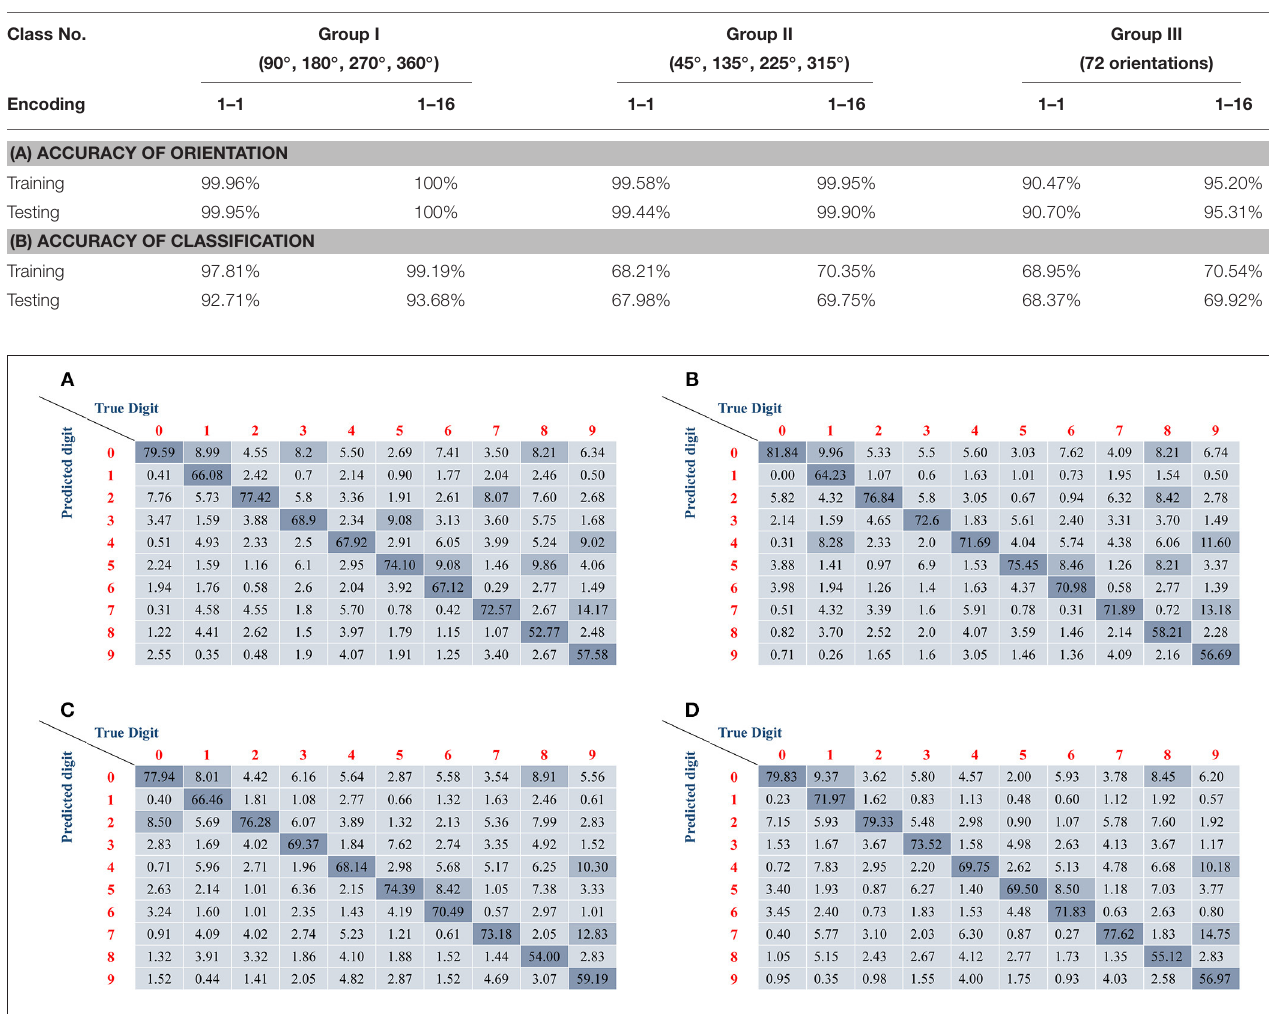
TABLE 3 | Accuracy of multiple orientation object recognition. Class No.